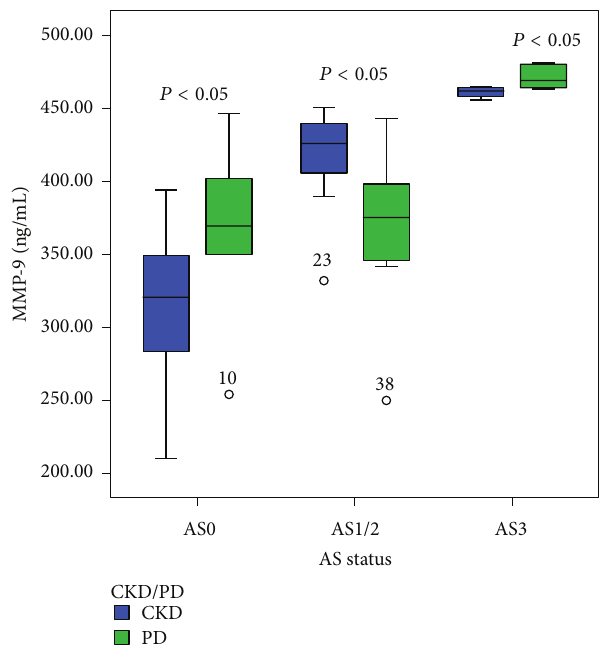
Figure 2: The relationship between serum concentrations of MMP- 9inCKDnondialysis-dependentpatientsandPDpatientsaccording to the stage of atherosclerotic changes in the carotid arteries. Data are presented as median with interquartile range. Bars show the maximum and minimum value, while the square and its central bar show median and interquartile range. Note: AS: atherosclerosis.